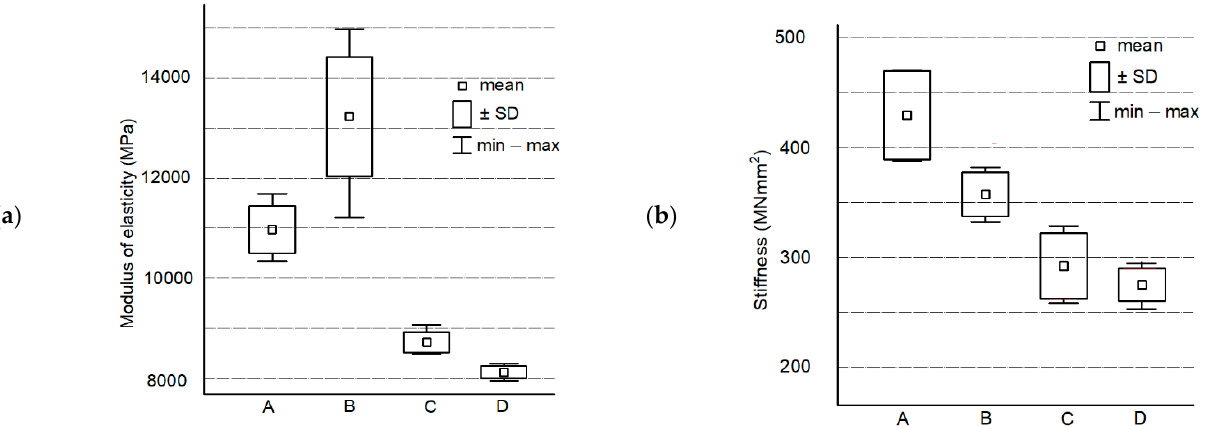
Figure 7. Results of fatigue in bending after air conditioning under conditions of 22 °C and 50% air humidity: ( a ) MOE; ( b ) stiffness.